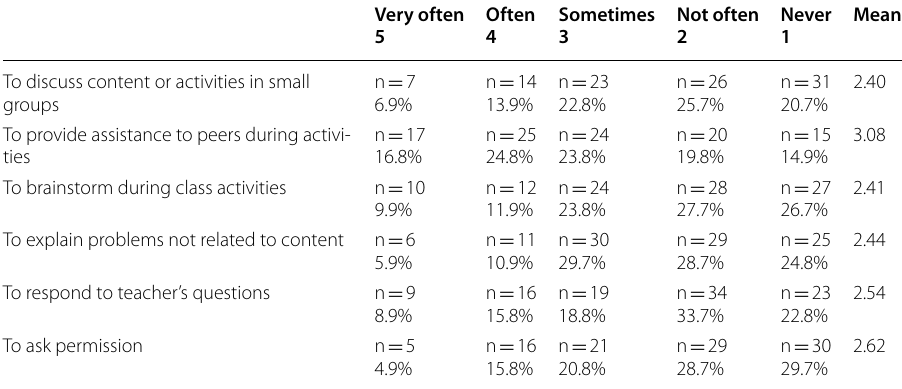
Table 6 Teachers’ self-reported encouragement of the students’ use of their native language(s)